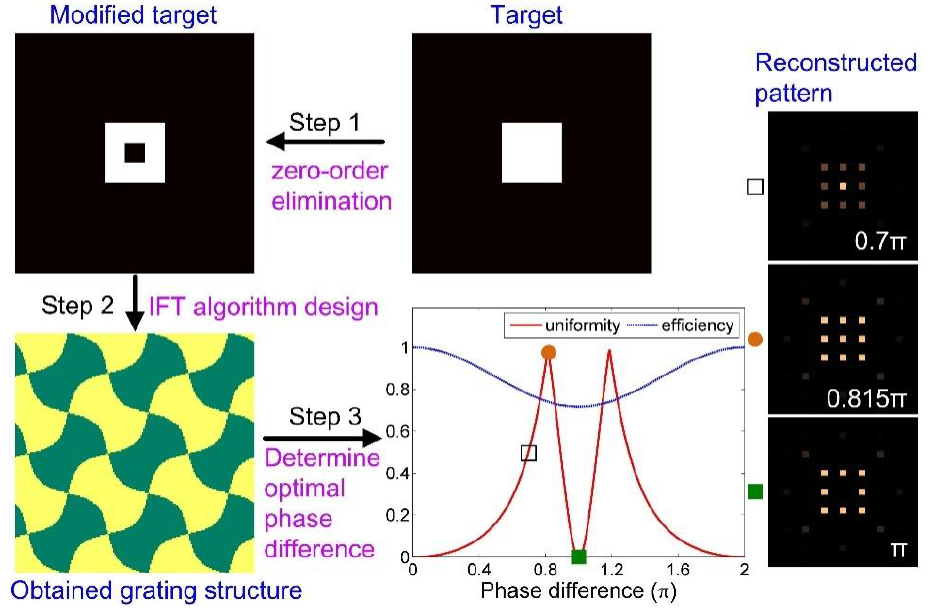
Figure 2. Schematic diagram of the proposed method.